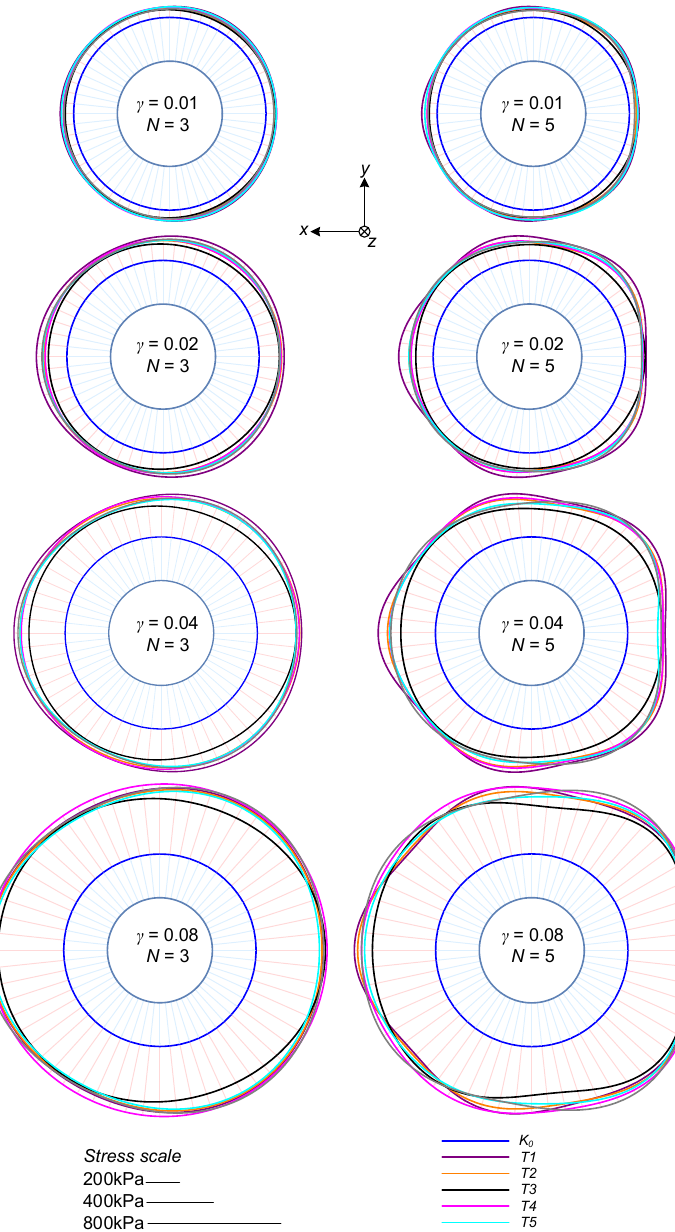
Figure 9. Contact stress distributions at different stages of the shear